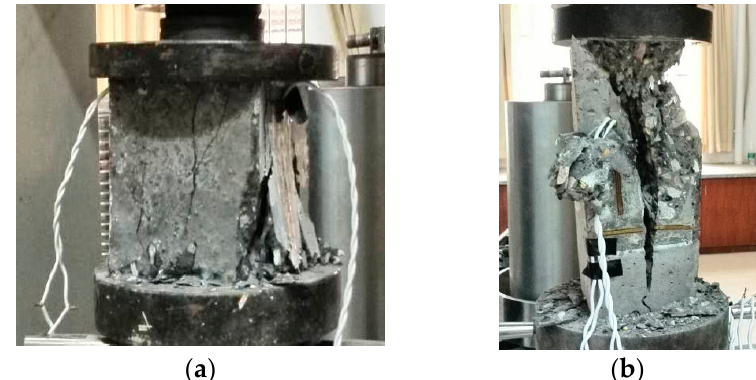
Figure 6. Failure modes of SCC under monotonic compression. ( a ) Cube specimen and ( b ) prismatic specimen.